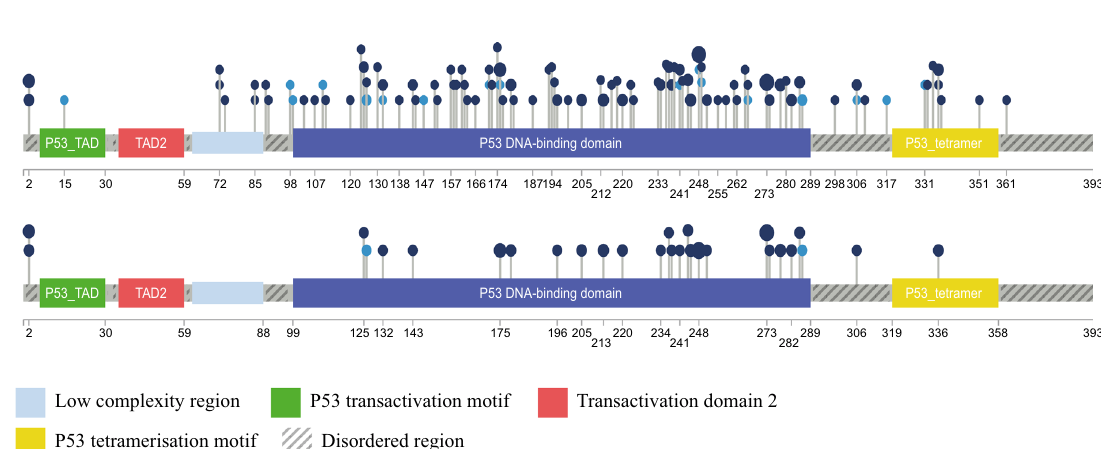
Fig. 3 Genomic alterations associated with sensitivity toward MI-773. a Volcano plot showing the mutated genes positively or negatively associated with the MI-773 Abs IC 50 values. x -axis, the difference between mean Abs IC 50 in wild type vs. mutated groups, y -axis: p -values in log 10 scale. Green dots: association with lower MI-773 Abs IC 50 , red dots: with higher Abs IC 50 (two-sided Wilcoxon p -value < 0.05), grey dots: association not signi fi cant ( p -value ≥ 0.05). b Boxplot of MI-773 Abs IC 50 in the TP53 wild type (WT TP53 ) and mutant (MUT TP53 ) groups. p -Value was obtained from the two-sided Wilcoxon test. Box limits are the 1st and 3rd interquartile; the inner horizontal line is the median, whiskers extend 1.5 times the interquartile range from the 1st and 3rd interquartile, data points were plotted as black dots. c The association between CL sensitivity to MI-773 and TP53 status. The upper panel shows a waterfall plot of the MI-773 Abs IC 50 of all 237 CLs. The lower panel shows the mutation status of the TP53 gene in the corresponding CLs. d Lollipop plot showing the location on p53 protein domains of the TP53 mutations identi fi ed on the 237-CL panel. Top: all TP53 mutations, bottom: mutations retrieved in more than one model (recurrent). The colours of the circles re fl ect the response classes to the